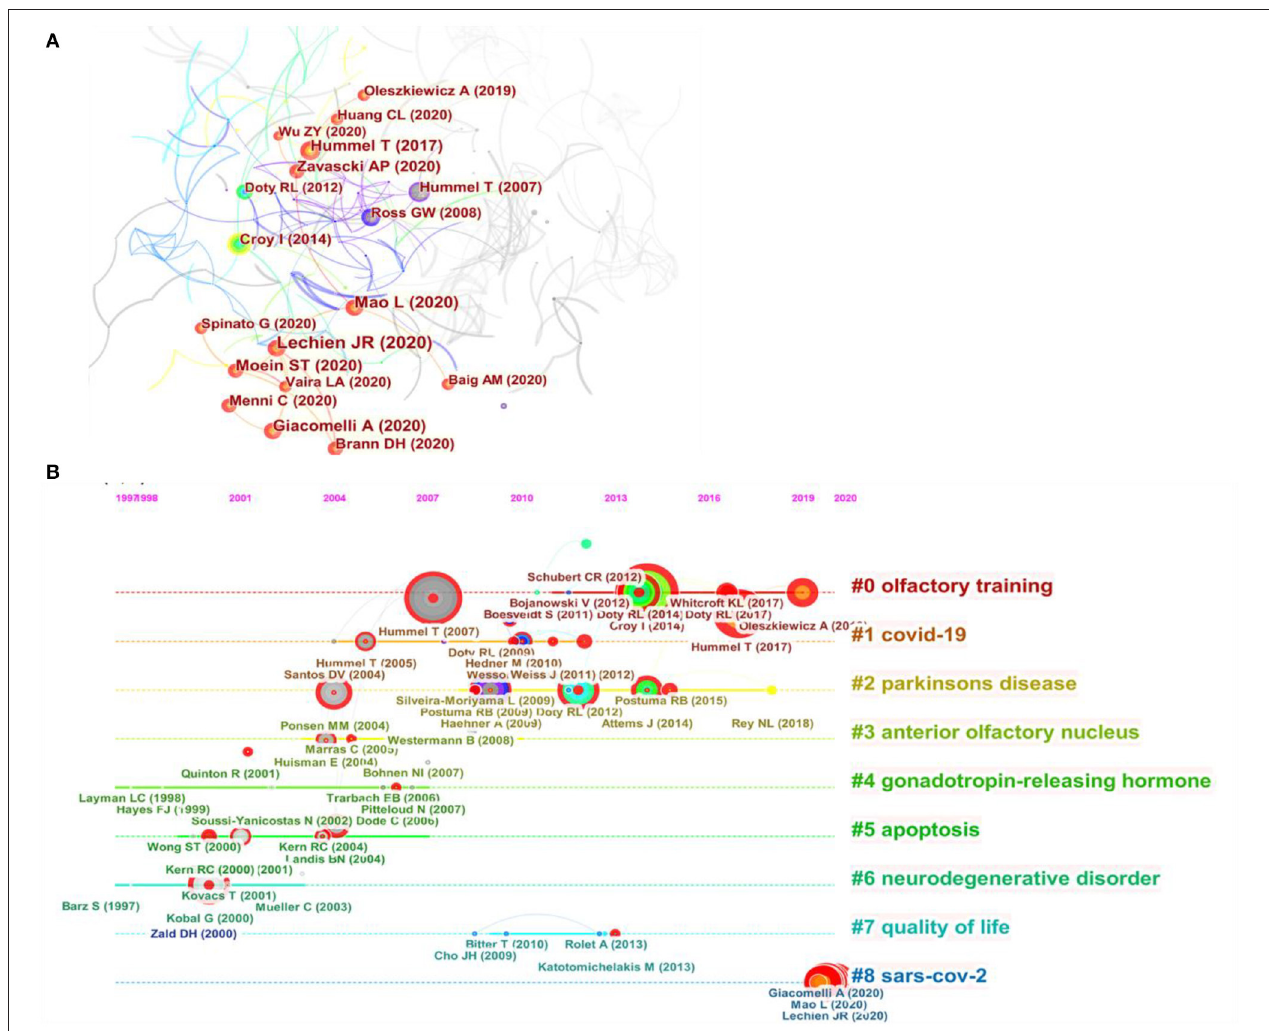
FIGURE 6 | A network map showing the co-cited references (A) and the timeline view of co-cited clusters with cluster labels (B)